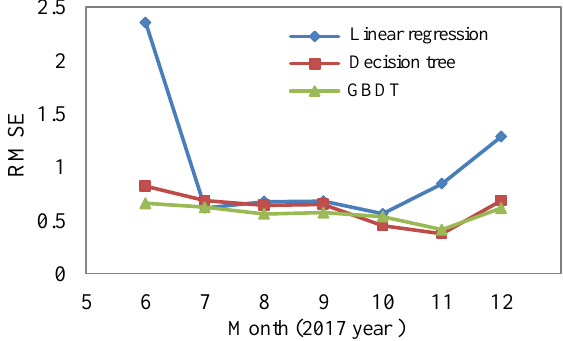
Figure 10. Transition of RMSE for each method per month.